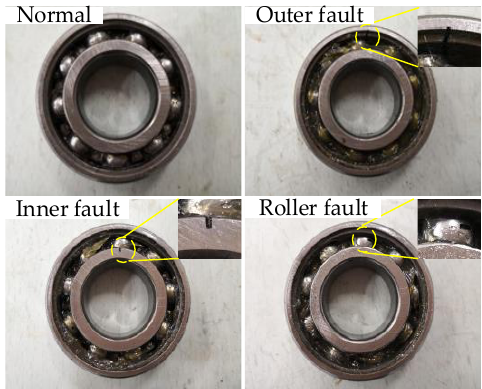
Figure 7. Physical pictures of fault bearing.